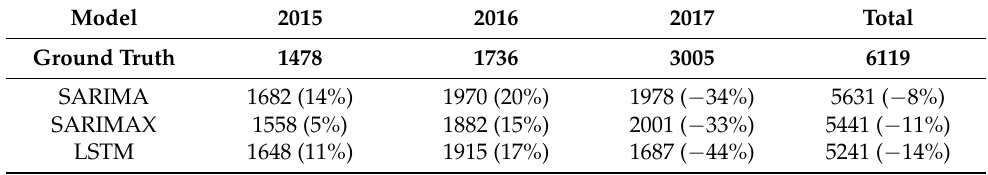
Table 2. Summary of the prediction year-by-year of the 3 models studied.